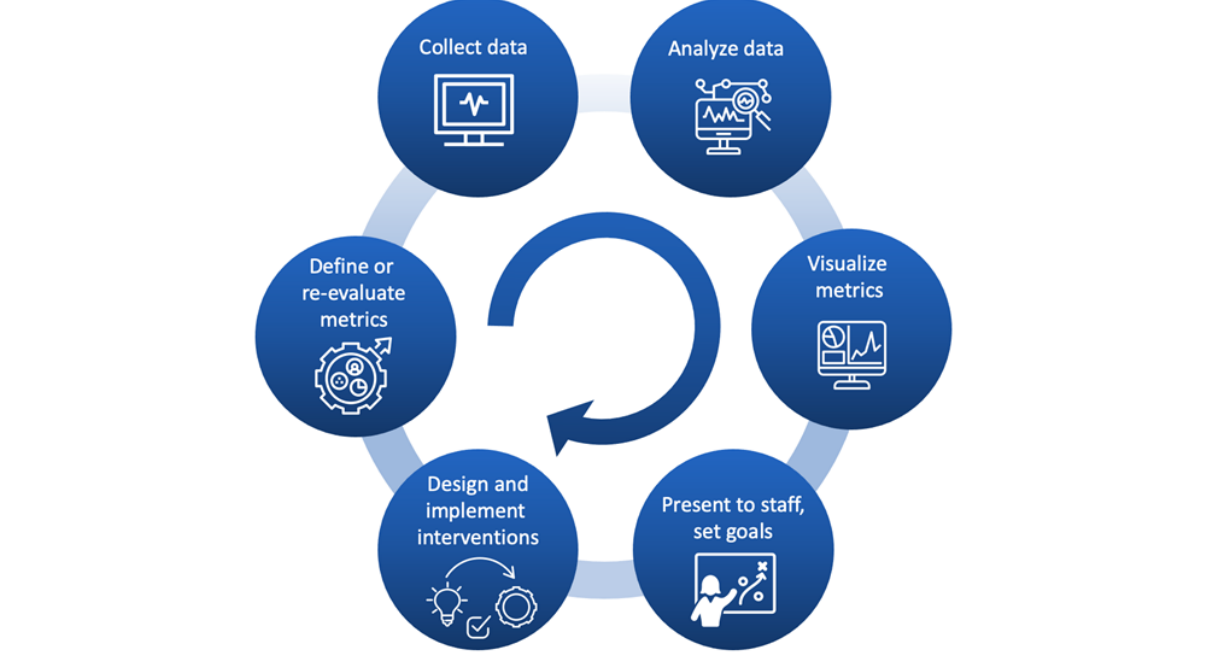
Figure 1. Feedback loop regarding do-it-yourself (DIY) instructions for self-analysis of patient monitoring alarm data in the intensive care